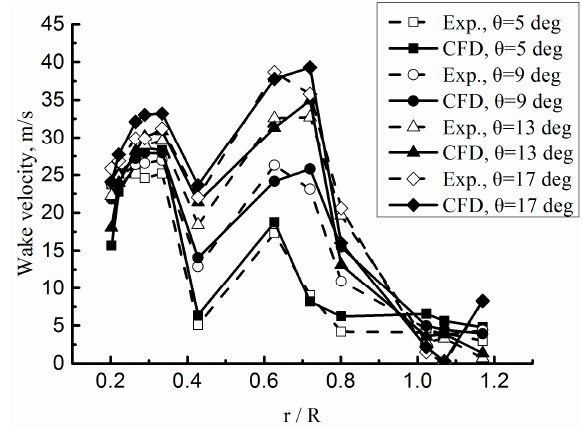
Figure 4. Comparison between the predicted and experimental results for the wake velocity.